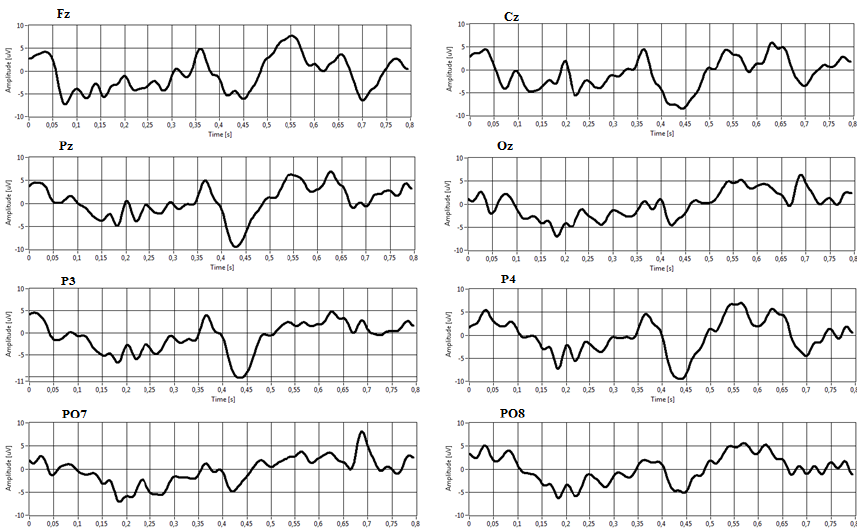
Figure 11. Examples of averaged target epochs.